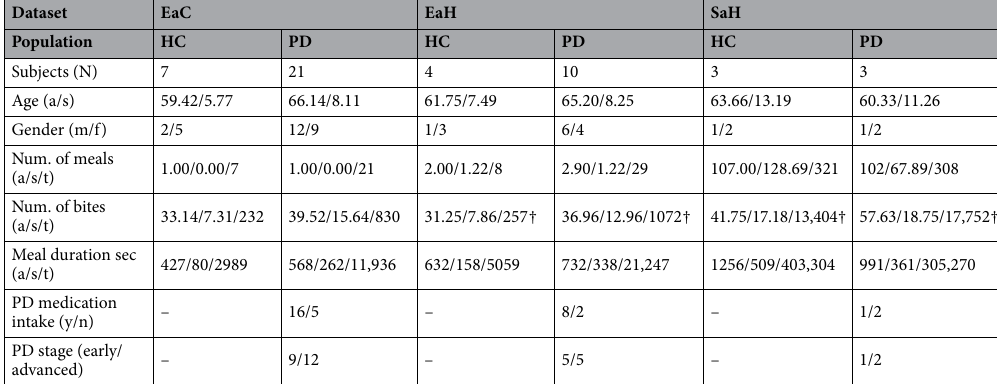
Table 1. Table presenting the technical and demographical information from the three datasets that were used in the scope of this work—namely, EaC, EaH and SaH. For each one of the datasets, information is provided regarding the PD and HC populations separately. It should be noted that in the case of in-the-wild datasets (EaH and SaH) no ground truth (GT) information exists in terms of number of bites. For the purpose of completion, we provide this information on calculations based on the number of detected bites (signified by the † symbol next to the cell). Meal duration is calculated as the difference of the timestamps between the last and the first bite (GT bites for EaC and detected bites for the in-the-wild datasets). Finally, the notation a/s/t is used to signify average/standard deviation/total, a/s for average/standard deviation, y/n for yes/no and m/f for male/ female.